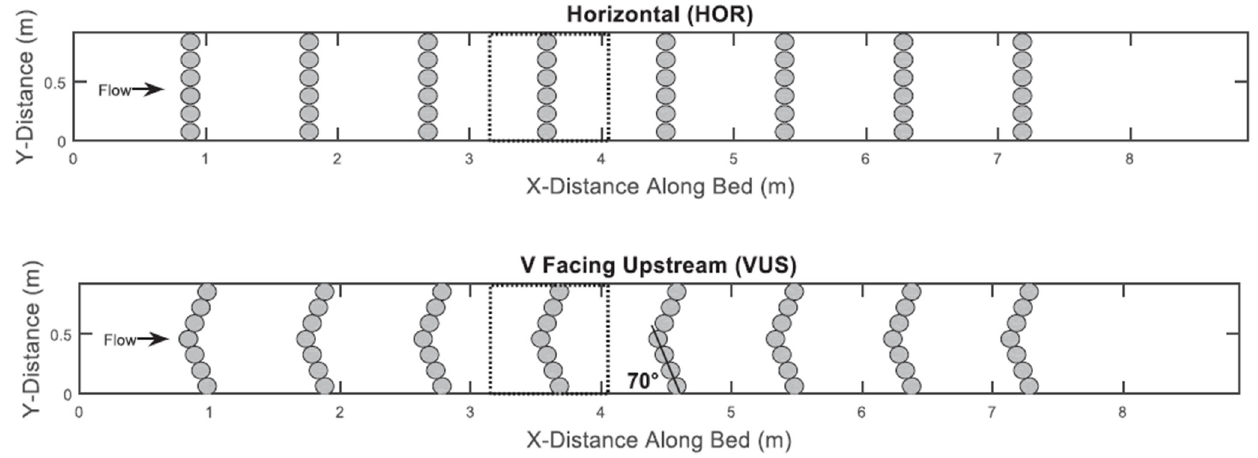
Figure 2. Plan view of the geometries used in the validation, taken from [45]. (1, 1.25, 1.5, 1.75, 2 cm), the artificial viscosity coefficient α (0.001, 0.01, 0.025, 0.05, 0.1), the inclusion of the SPS turbulence model with a kinematic viscosity value of 10 − 6 m 2 s, and the effect of viscosity at the boundaries through the parameter denoted α bf (the default value in this work being α bf = 0). Comparisons are given in Figures 3–5.